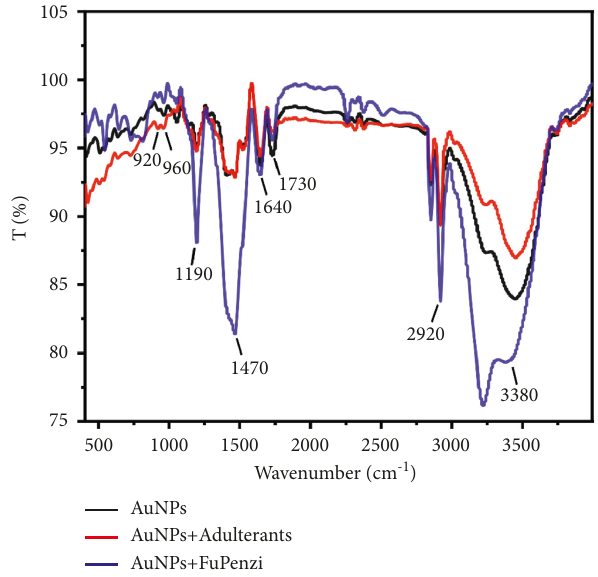
Figure 5: FT-IR spectrum of Fupenzi, adulterants, and AuNP